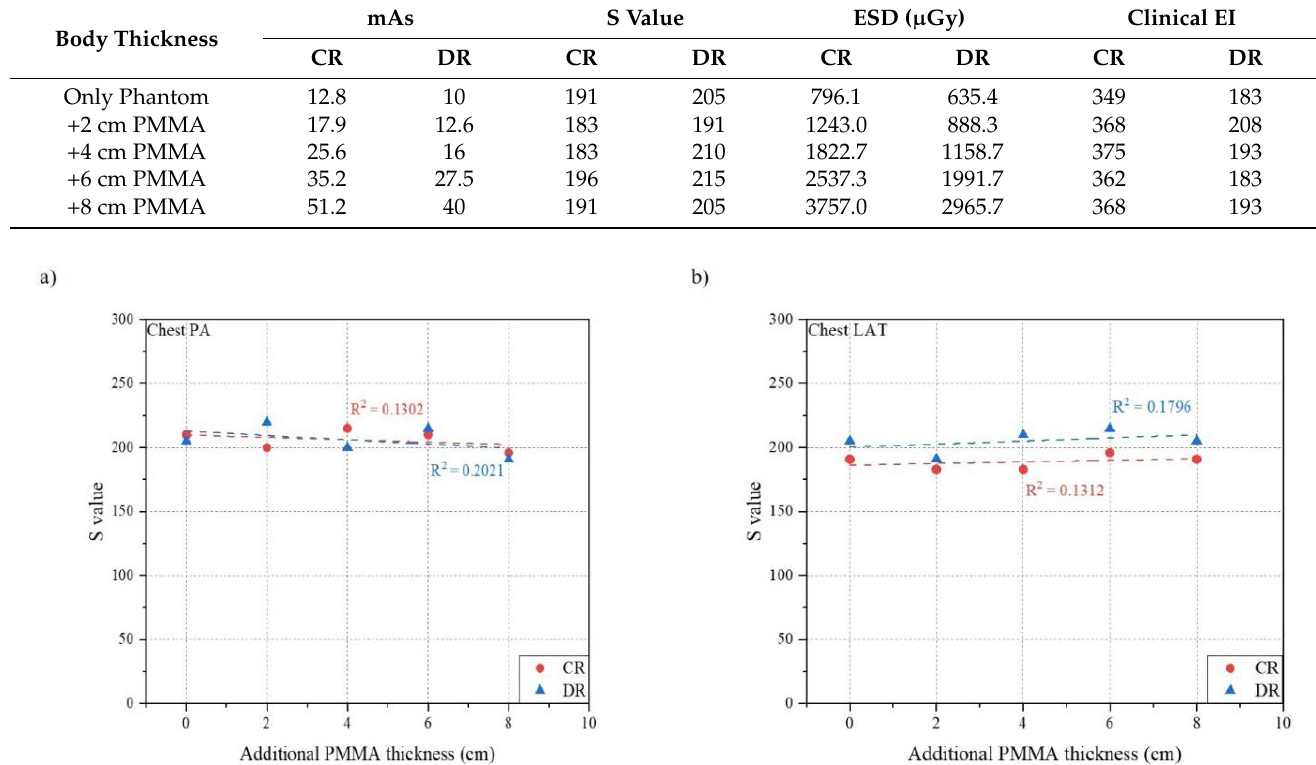
Table 4. Result of tube current time product, S value, entrance surface dose, and clinical exposure index for chest radiography (LAT projection).